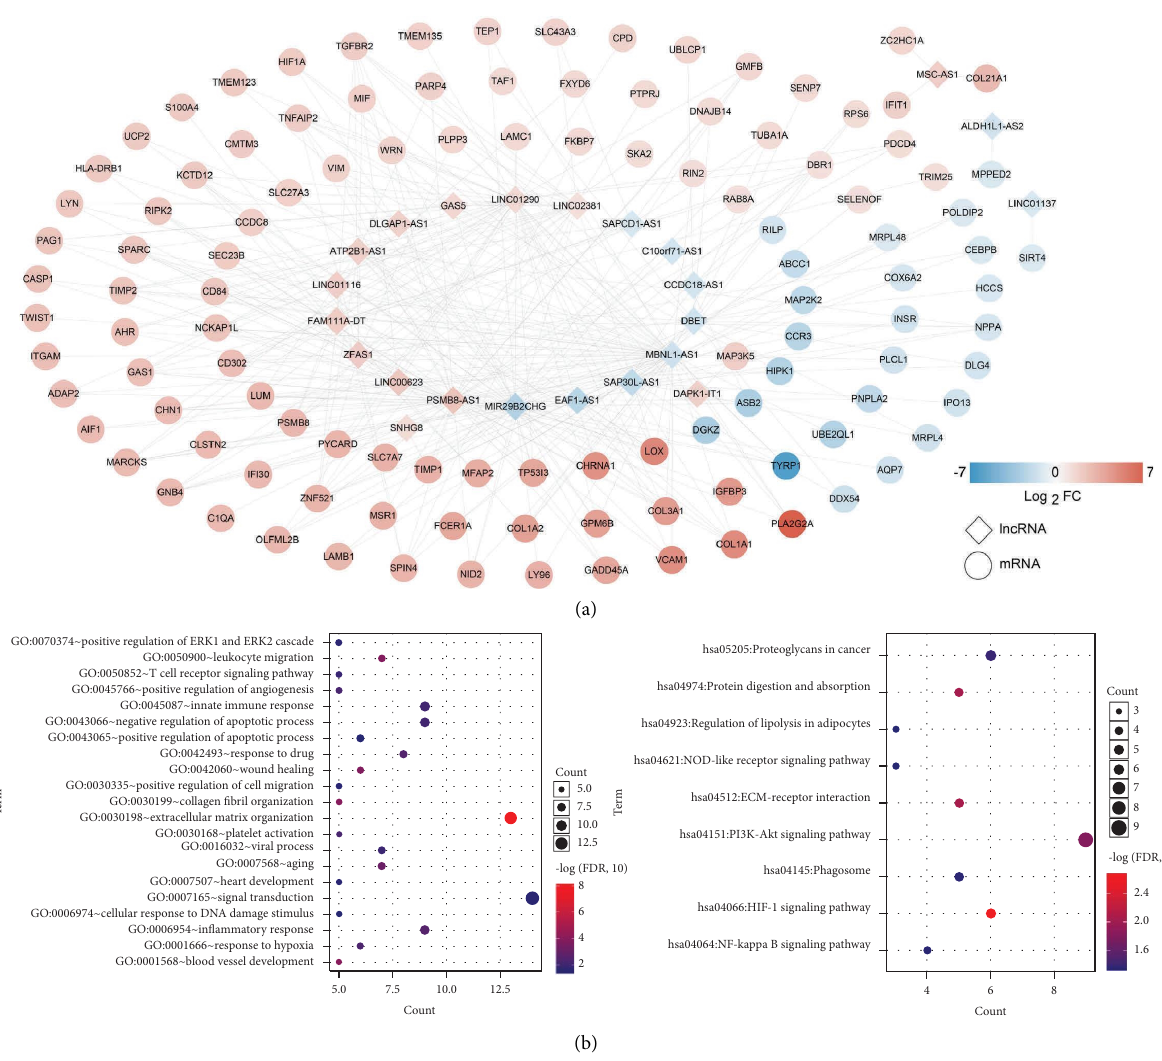
Figure 4: Establishment of a coexpression network of lncRNA-mRNA and functional analyses of the factors in this coexpression network. (a) A coexpression network of lncRNA-mRNA was constructed with the lncRNA-mRNA pairs ( P < 0 . 05 and PCC > 0.9). Diamonds and circles represent lncRNAs and mRNAs, respectively. A change in spot color from blue to red indicates a change in the degree of signifcant diference from downregulation to upregulation. (b) Signifcantly enriched GO terms of biological process (left) and KEGG signaling pathways (right) of the genes in this coexpression